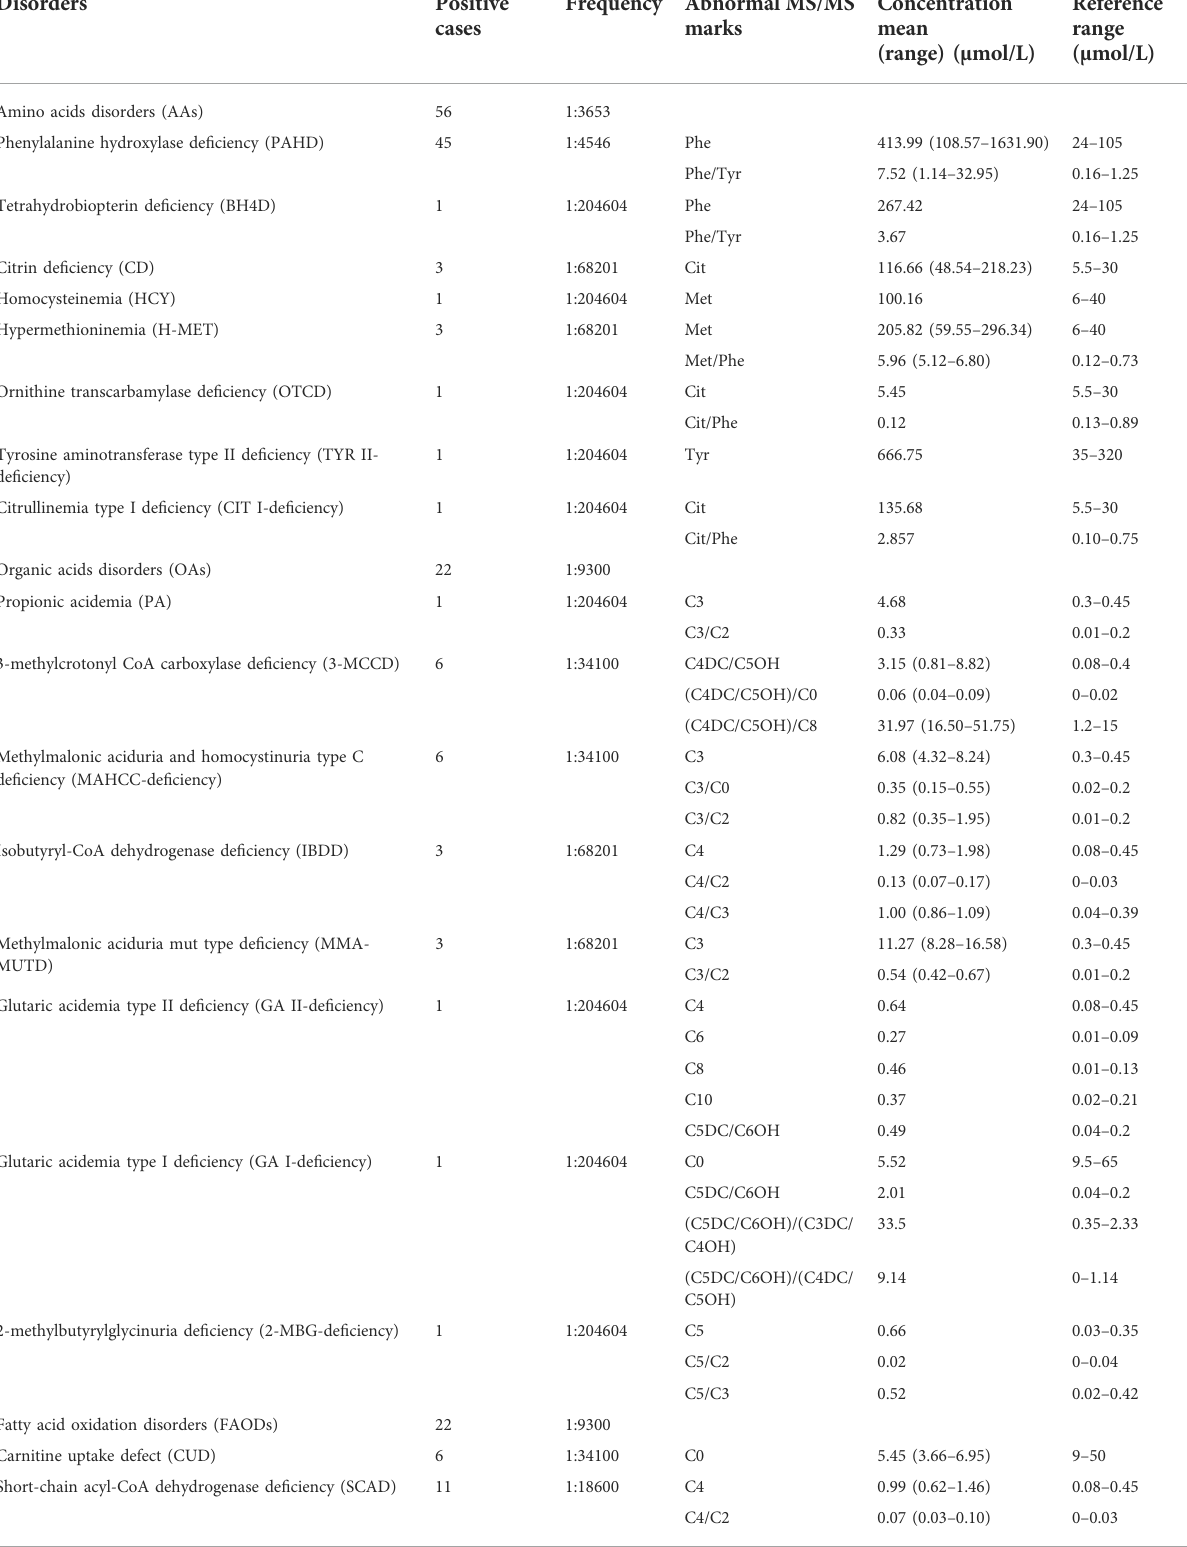
TABLE 1 Abnormal MS/MS markers and results statistics of all con fi rmed